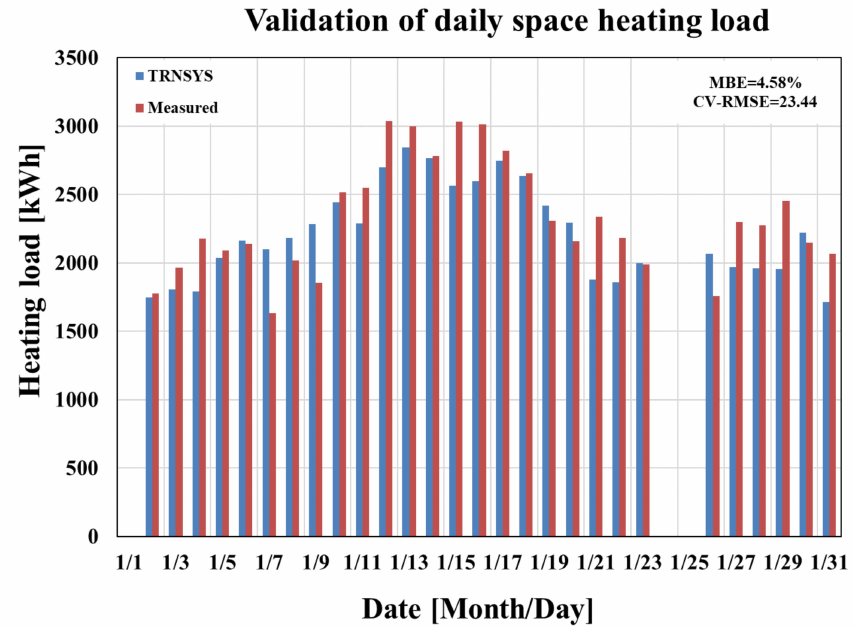
Figure 8. Validation of the daily heating energy consumption between the simulation data and measured data.